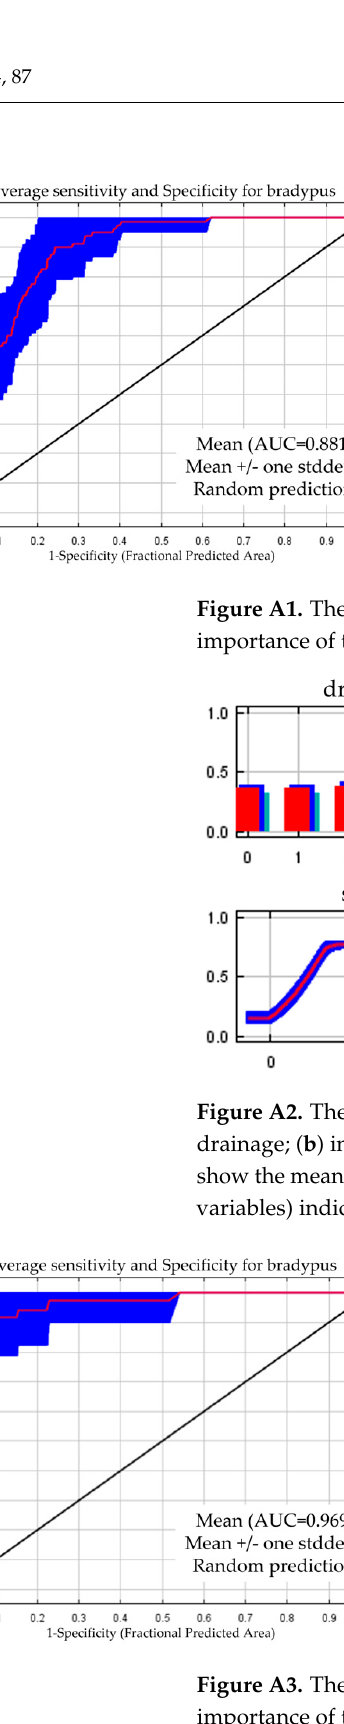
Figure A3. The receiver operating characteristic (ROC) curve of Q. acuta ( a ); the Jackknife tests the importance of the training of variables to distribution of Q. acuta ( b ).